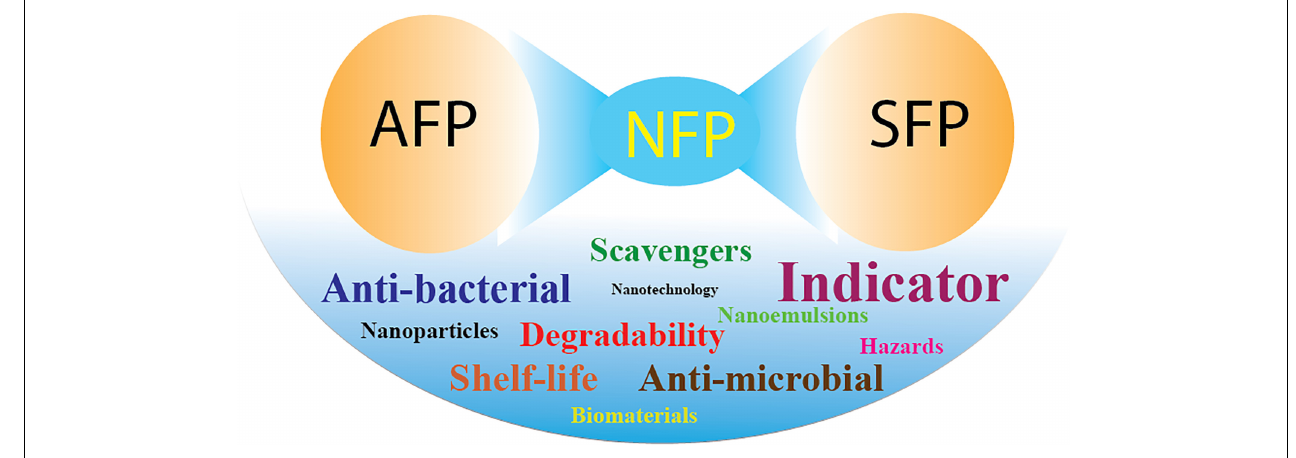
FIGURE 1 | New types of food packaging systems and their